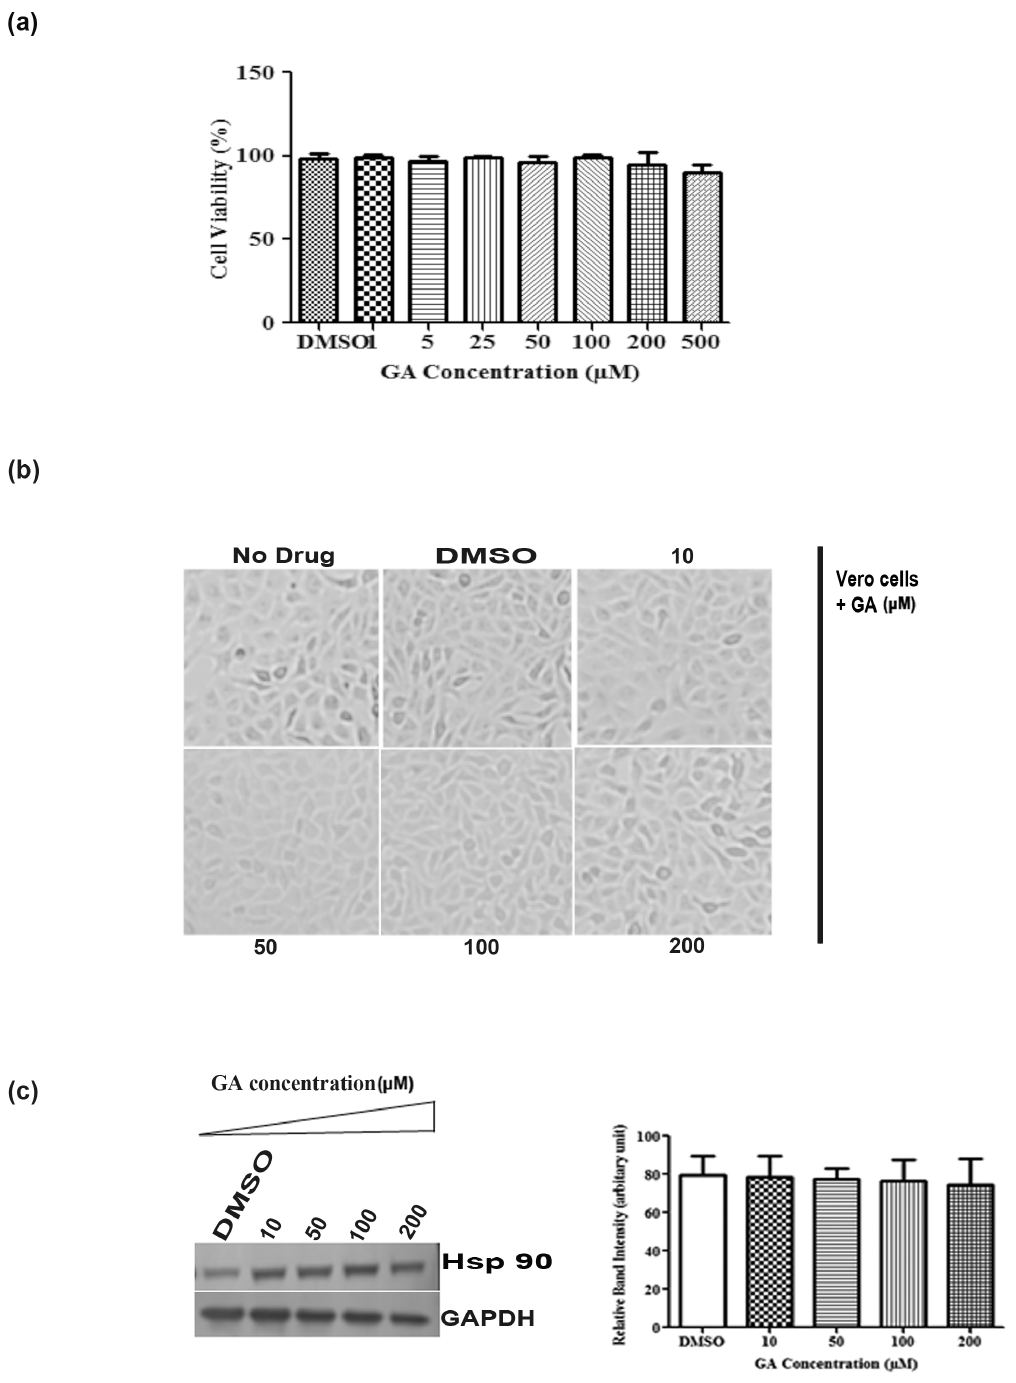
Figure 1. Determination of the cytotoxicity of Hsp90 inhibitor, Geldanamycin (GA). (a)Vero cells were treated with different concentrations of GA (1, 5, 25, 50, 100, 200, 500 m M) for 14 h and the cytotoxicity of the cells were determined by MTT assay. Cellular cytotoxicity was determined in duplicate and each experiment was repeated three times. (b) Cells were observed under microscope (Magnification -10X) for cytotoxicity with increasing concentration of the drug (10, 50, 100, 200 m M) on Vero cells at 14 h. (c) Vero cells treated with (10, 50, 100, 200 m M) of GA were harvested at 24 h, lysed and expression of Hsp90 was analysed in Western blot by probing with Hsp90 antibody. GAPDH served as the loading control. The changes in the band intensity was quantified by normalizing GAPDH and the relative band intensity has been shown as bar diagram in right panel (n=3; p , 0.05).